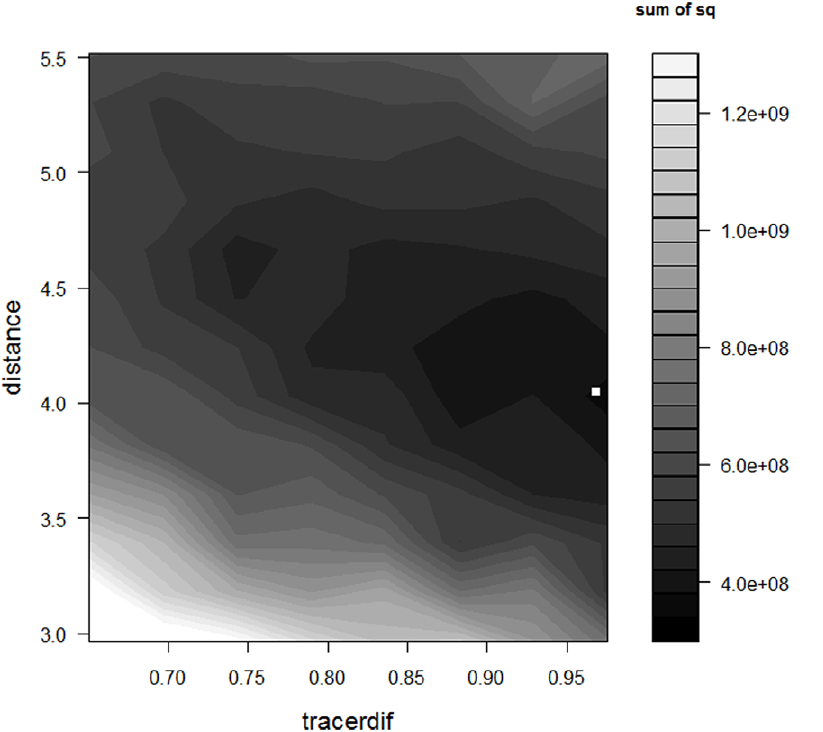
Figure 3. Visualisation of the sensitivity analysis ( ± 30%) for the activity parameter and the parameter accounting for density differences between luminophores and non-marked particles, ‘ density ’. Low values of the objective function (dark grey shades) indicate a good fit between model predictions and the observed data. The white square indicates the location of the optimised parameter combination. Sum of sq=sums of squares.